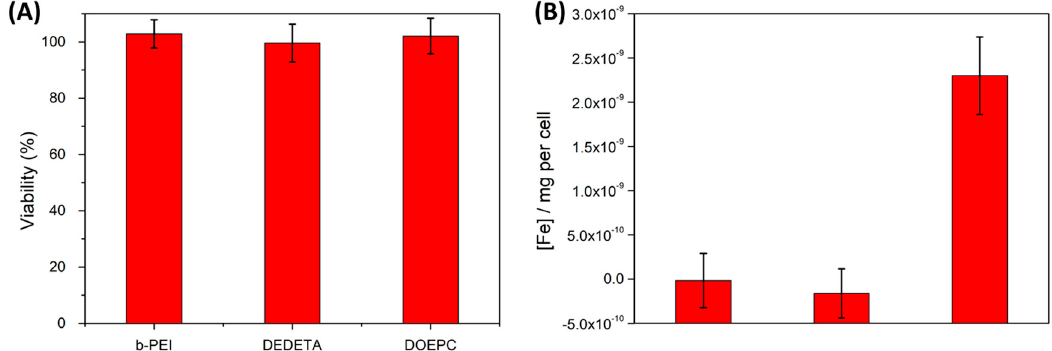
Figure 7. Cytotoxicities ( A ) and iron uptake data ( B ) of HeLa cells after 12 h of incubation with various polymersome preparations comprising the cationic modifications listed in the graphs, at 300 µg/mL amphiphile concentration. Cytotoxicity assays did not show any measurable decrease in cell viability among the different preparations within the accuracy of the method. Iron content data (normalized